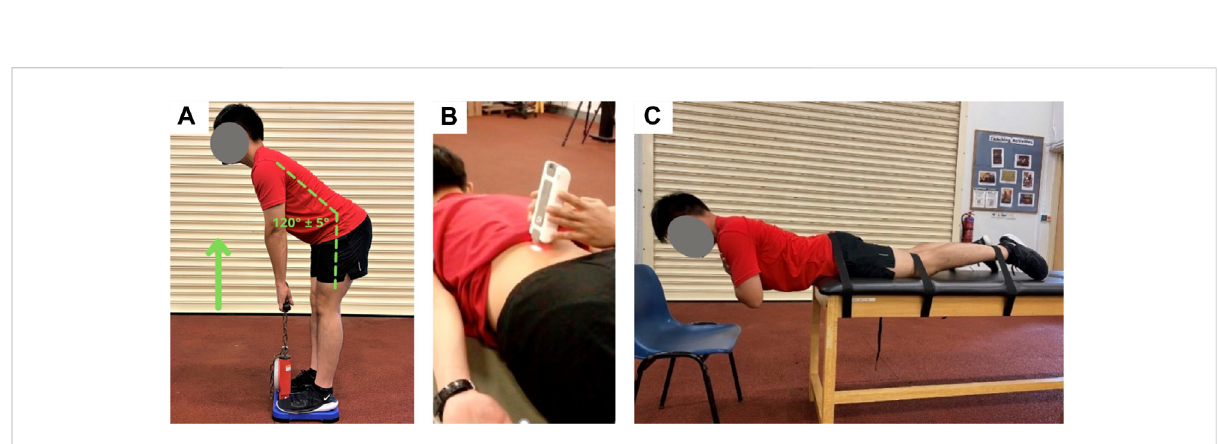
FIGURE 3 Backmusclecharacteristicsassessment: (A) Maximalisometrichipextensiontest, (B) Passivestiffness oflumbarextensor muscles, (C) Modi fi ed Sorensen test for